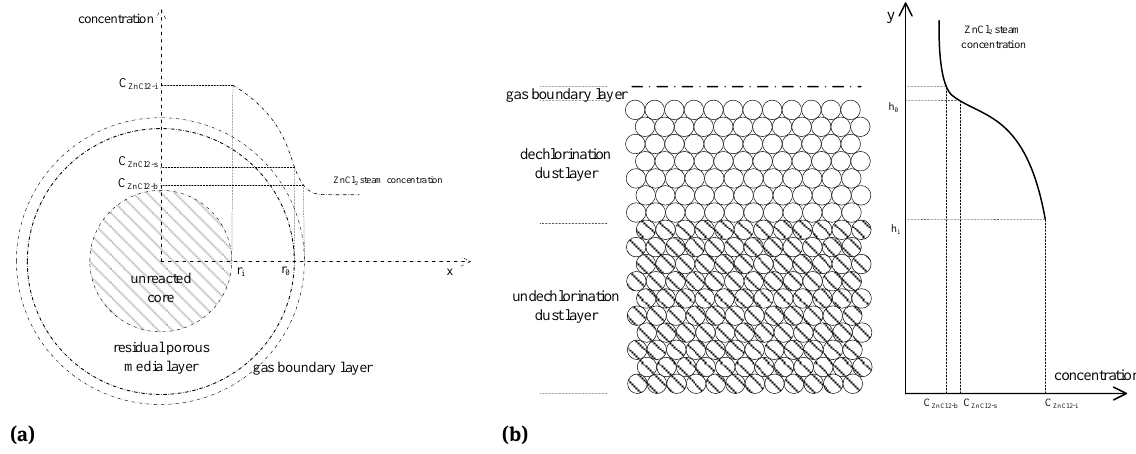
Figure 3: Shrinking unreacted core model of the dust dechlorination process with a constant particle size